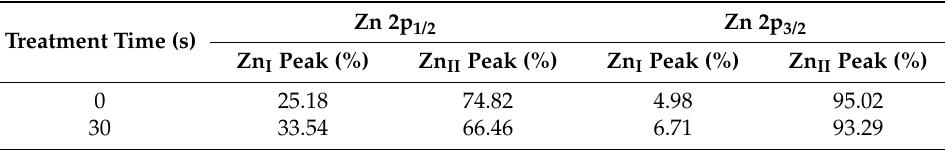
Figure 10. XPS spectra and the Gaussian-resolved components of the Zn 2p 3/2 peak for FZO films on unmodified and 30 s pretreated PI substrates. ( a ) Unmodified and ( b ) O 2 plasma pretreatment time of 30 s. Table 2. Areas of the Zn 2p 1/2 and Zn 2p 3/2 peaks for FZO films on unmodified and 30 s pretreated PI